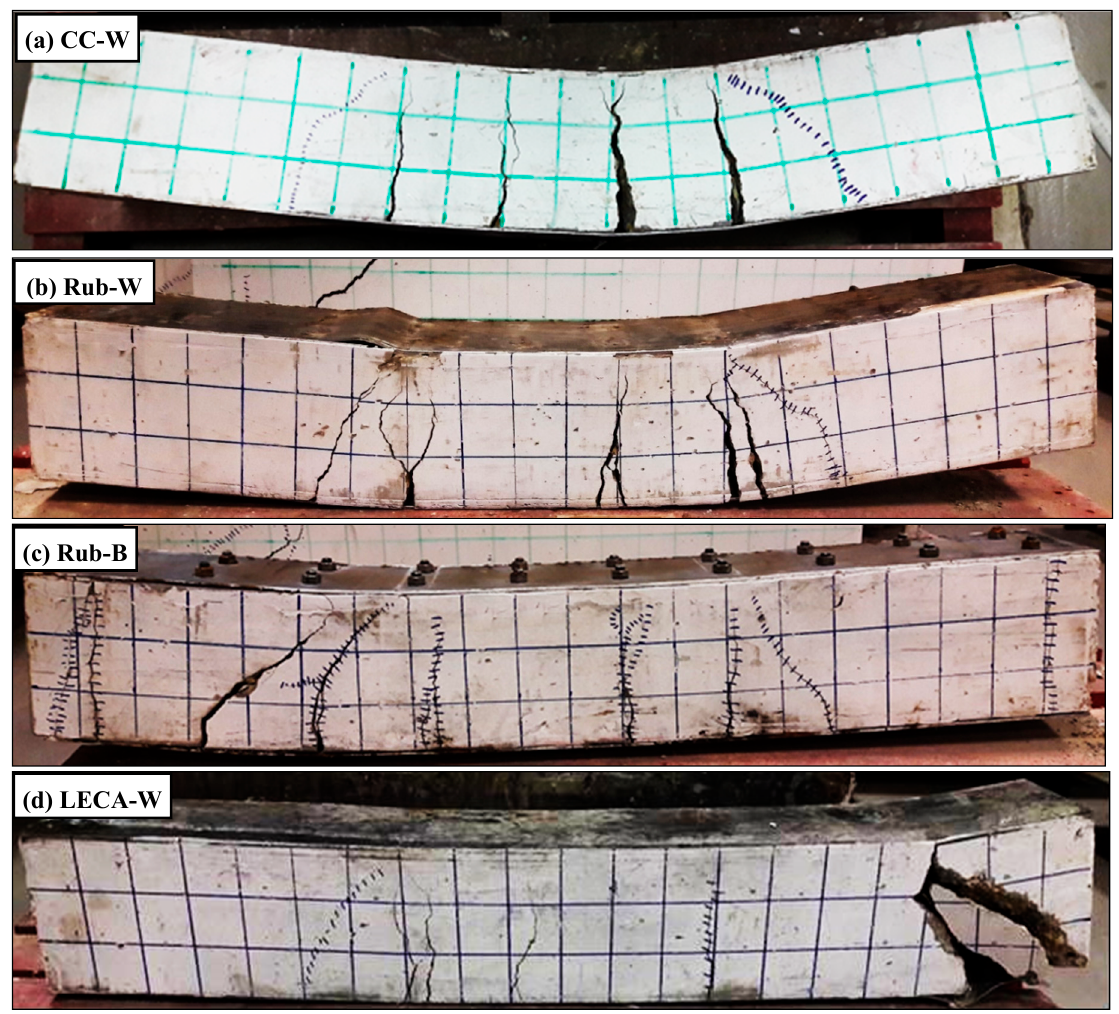
Figure 11. Damage pattern of the tested specimens: ( a ) CC-W, ( b ) Rub-W, ( c ) Rub-B, and ( d ) LECA-W.